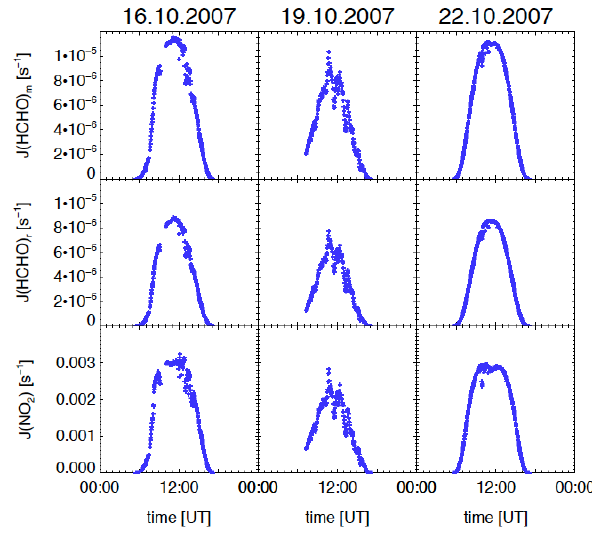
Fig. 4. The temporal evolution of HCHO and NO 2 photolysis fre- Figure 4: The temporal evolution of HCHO and NO 2 photolysis frequencies. 850 quencies. Molecular and radical channel photolysis of HCHO are Molecular and radical channel photolysis of HCHO are denoted J(HCHO) m and denoted J (HCHO) m and J (HCHO) r , J(HCHO) r , respectively.